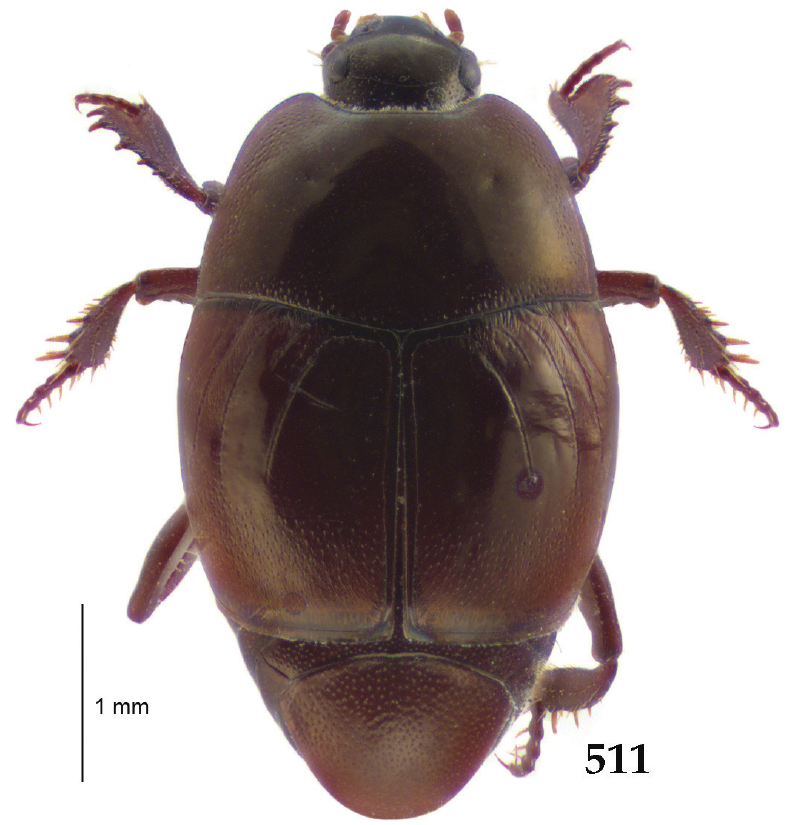
Figure 511. Saprinus ( Saprinus ) pseudodetritus sp. n. habitus, dorsal view. / 23.i.1998 J.W.M. Marris / under rock in low coastal vegetation (sward)” (printed) (LUNZ); 5 specs., “NEW ZEALAND, CI / Rangatira / 28.xi.1992 / P. Syrett / by petrel burrow at night” (printed) (LUNZ); 1 spec., ditto, but 29.i.1998 and on tree at night (LUNZ); 1 spec., “NEW ZEALAND, CI / Glory Scan Res / 30.xi.1992 / R.M. Emberson & P. Syrett” (printed) (LUNZ); 1 spec., “NEW ZEALAND, CI / Chatham I, Hapaupu / 2.xii.1992 / P. Syrett / on trees at night (printed) (LUNZ; 8 exs. in coll. TLAN); 1 spec., “Chathm. / gr. ? (illegible)” (written); “New Zealand” (printed); “Pascoe / Coll. / 93-60” (printed); “this specimen is / most likely from / the Chatham Islands / T. Lackner, 2014” (written); “Saprinus pseudodetritus / sp. n. PARATYPE / Det. Lackner & Leschen, 2014” (red label, written) (BMNH). Distribution. New Zealand: Chatham Islands: South East Island, Mangere